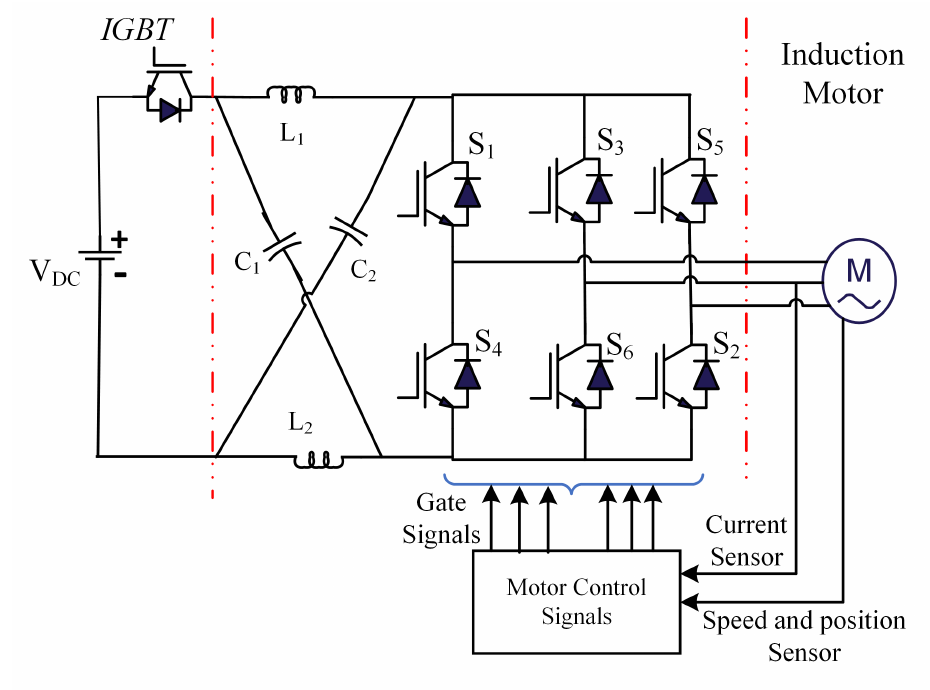
Figure 1. Generic schematic of a motor control